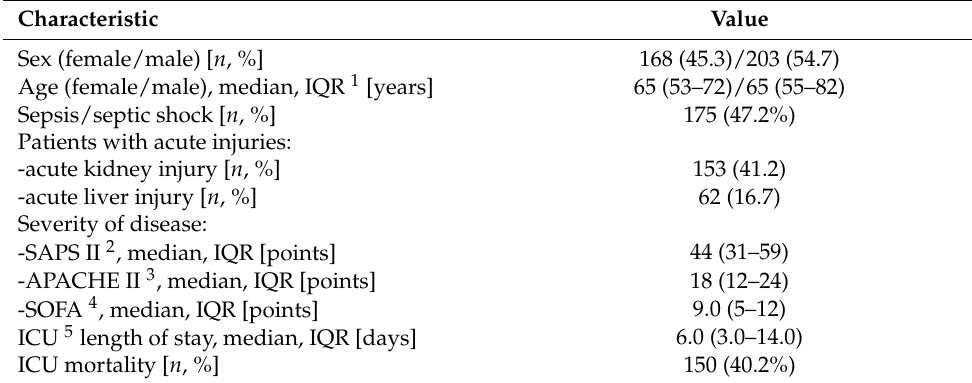
Table 1. Study population